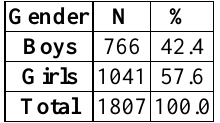
Table 1: Distribution of sample by gender